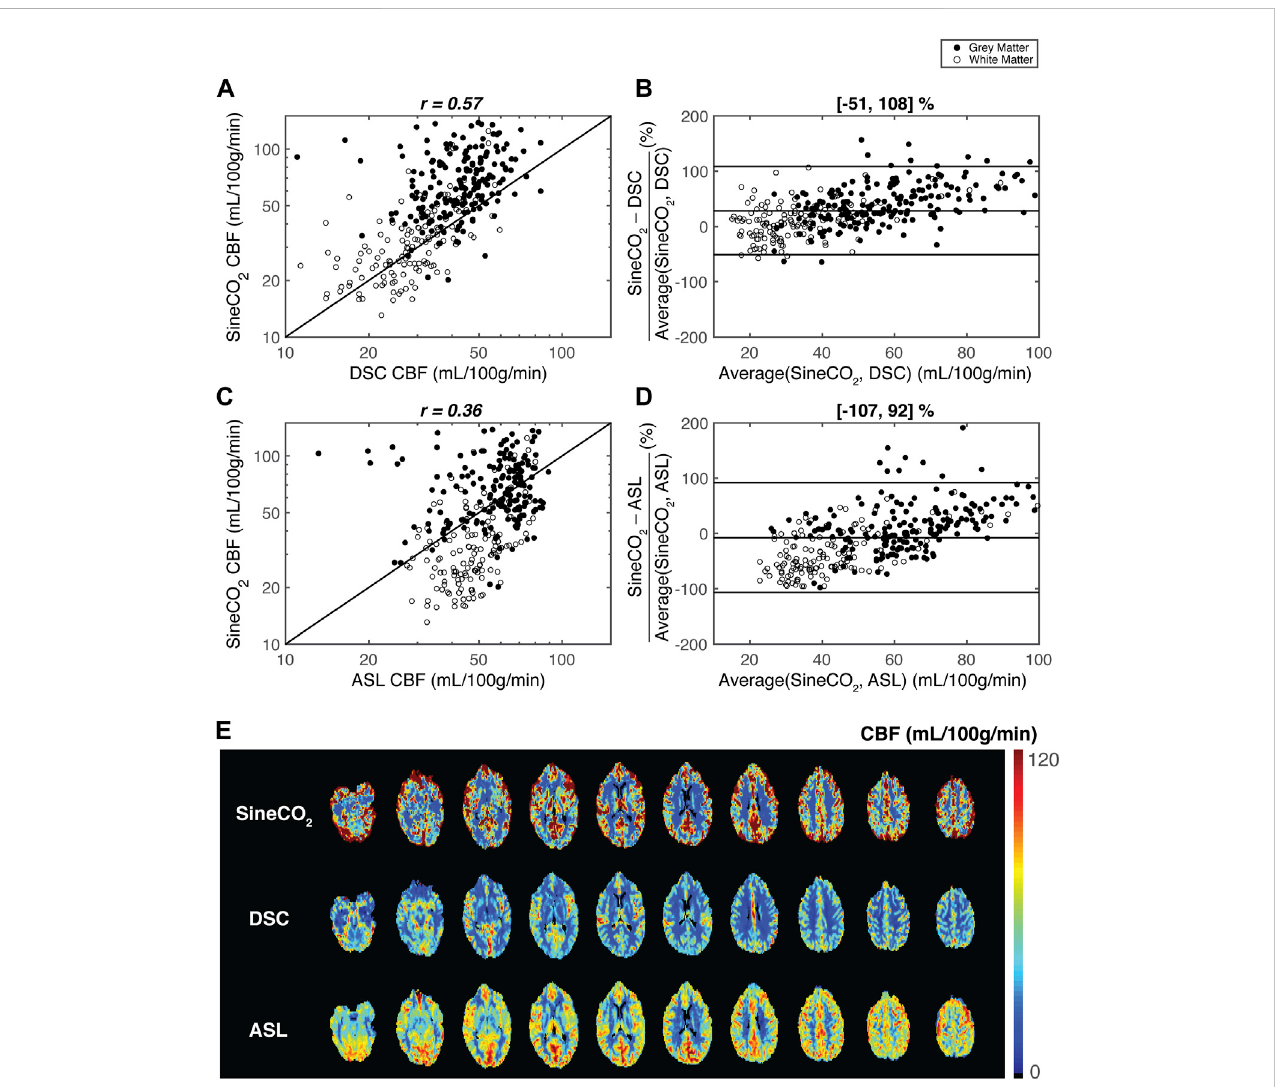
FIGURE 3 Regional agreement between respiratory challenge SineCO 2 and reference standards DSC and ASL in a representation subject. Correlation and Bland- Altman limits of agreement analyses using 312 regions-of-interest between (A – B) SineCO 2 and DSC and (C – D) SineCO 2 , and ASL (E) CBF maps in representative subject by three